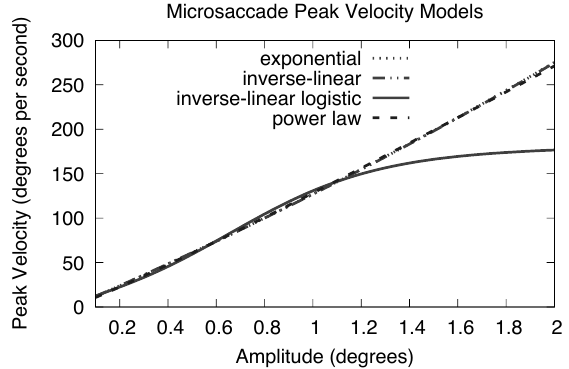
Figure 4 . Functions fit to microsaccade data of Exper- iment 2 (see text). Note that only the inverse-linear logistic function is able to fit both inflections at lower and higher amplitudes (e.g., ∼ 0 . 4 ◦ and ∼ 1 . 2 ◦ ). Data to which these fits were made are shown in Figure 8(a), see